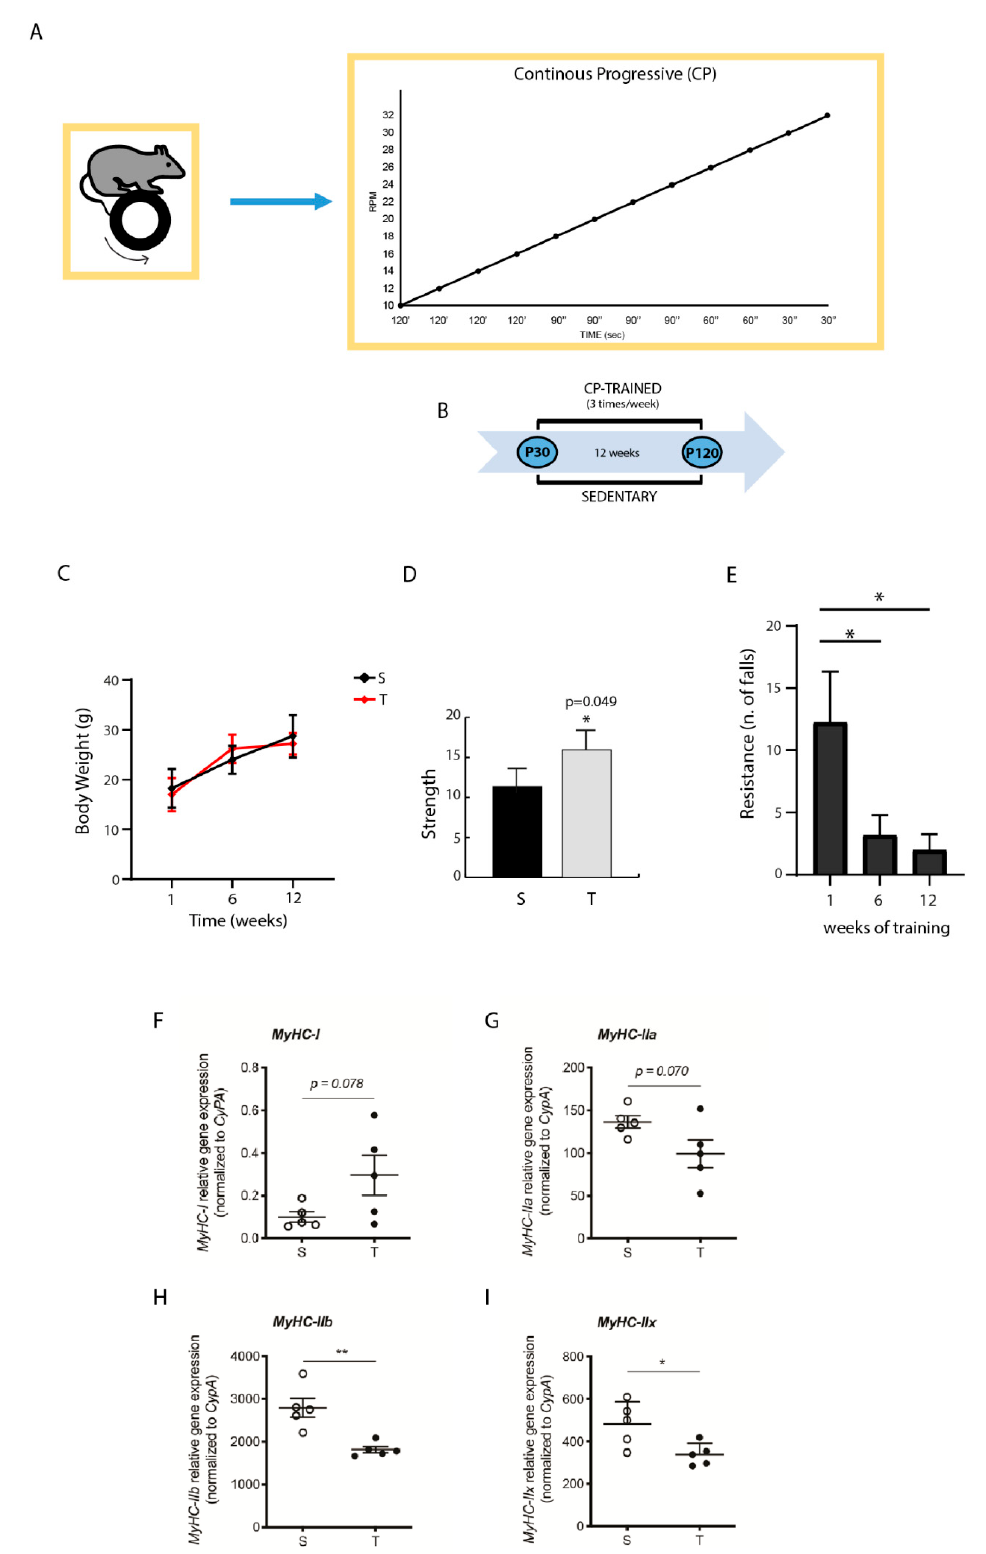
Figure 1. Continuous progressive (CP) aerobic exercise (AE) promotes physical performance and affects muscle fiber expression. ( A ) Schematic representation of CP exercise: CP program was carried out three times a week for a total time of 12 weeks. The training schedule is reported: 120” at 10 RPM, 120” at 12 RPM, 120” at 14 RPM, 120” at 16 RPM, 90” at 18